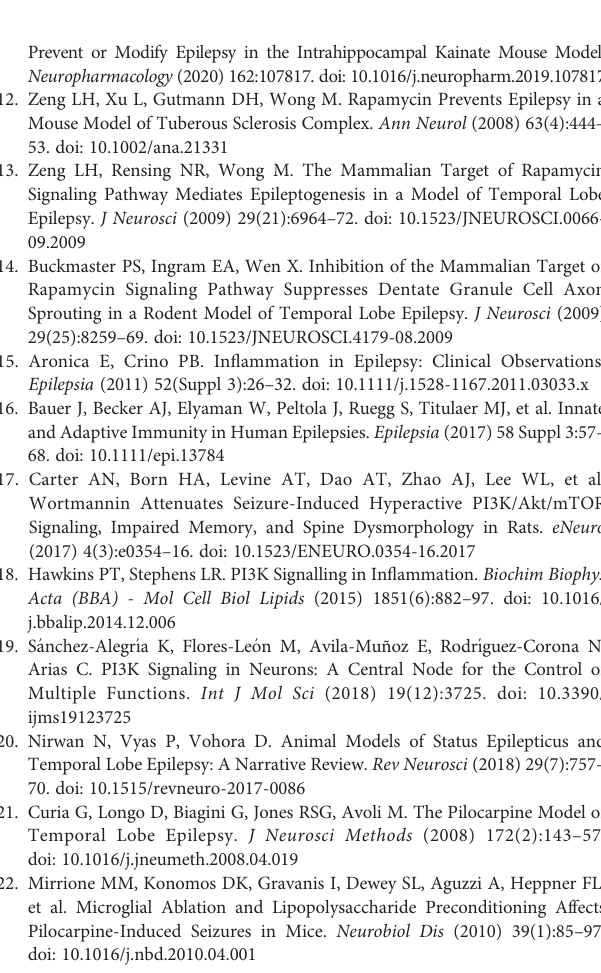
Supplementary File 5 | List of reagents, drugs and commercially available ELISA kids and